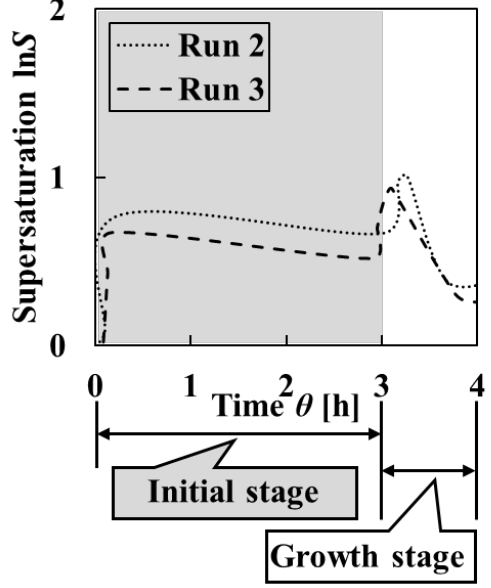
Figure 4. Changes in the supersaturations calculated from the measured pH and L-Asp concentration of the solutions in Runs 2 and 3. The crystallization stage when the initial particles were produced was defined as the initial stage, and the stage after that as the growth